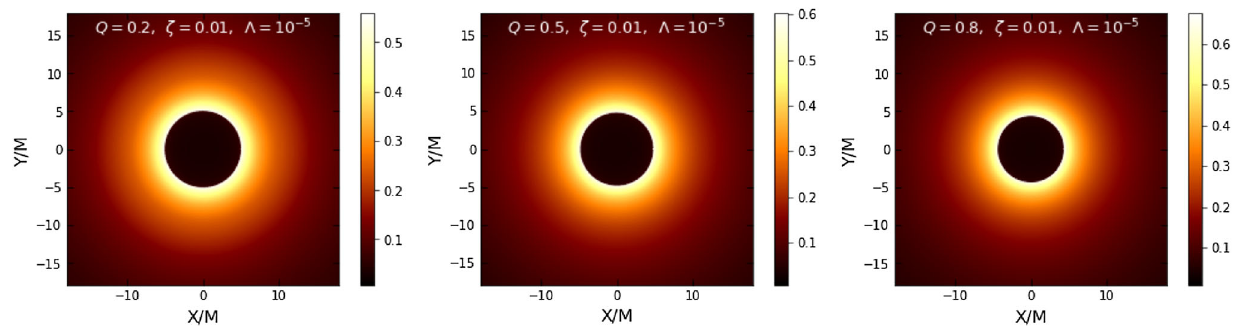
Fig. 5 The shadow images and the intensities for different values of Q . Note that the observer is located at distance r 0 = 30 M from the black hole